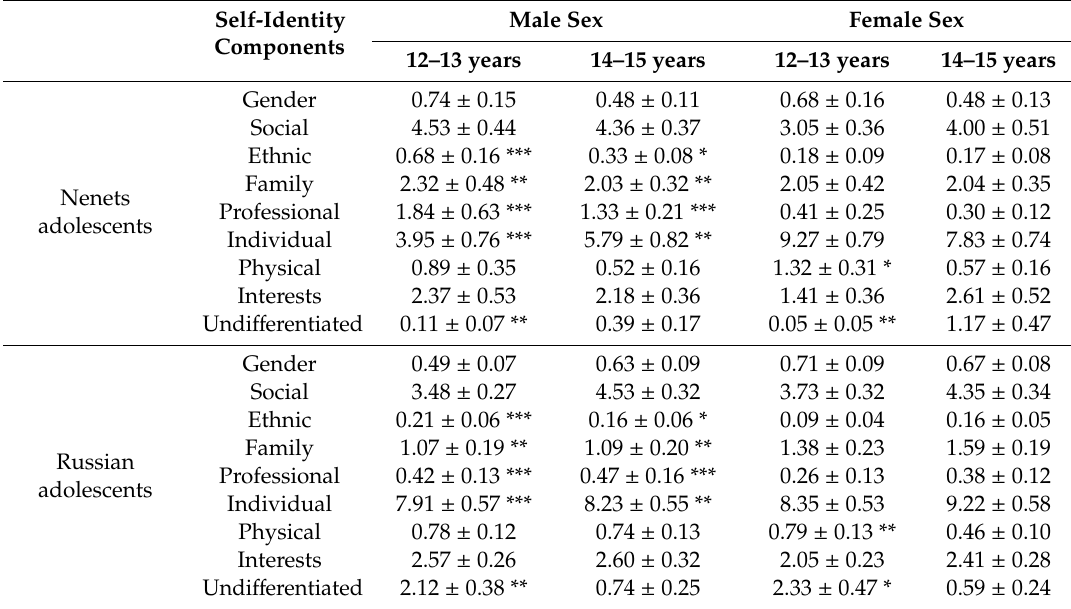
Table 1. Self-identity among Nenets and Russian adolescents.